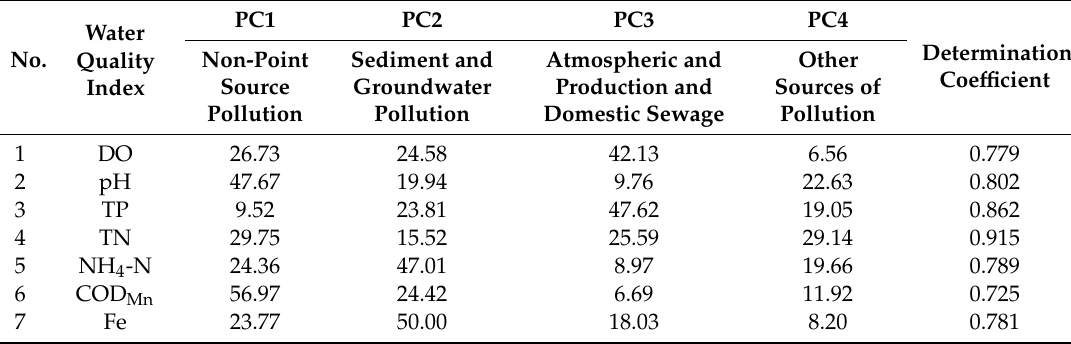
Table 5. Contribution of pollution source to each